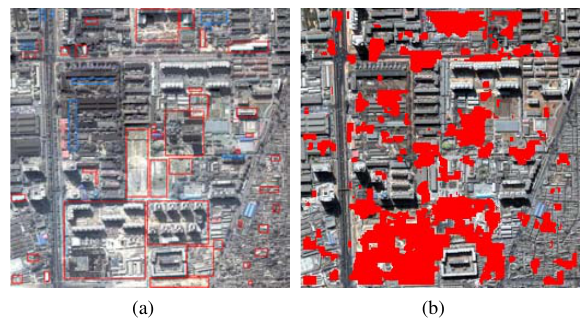
Figure 6: Results comparison. (a)reference change map. (b)change map by the proposed